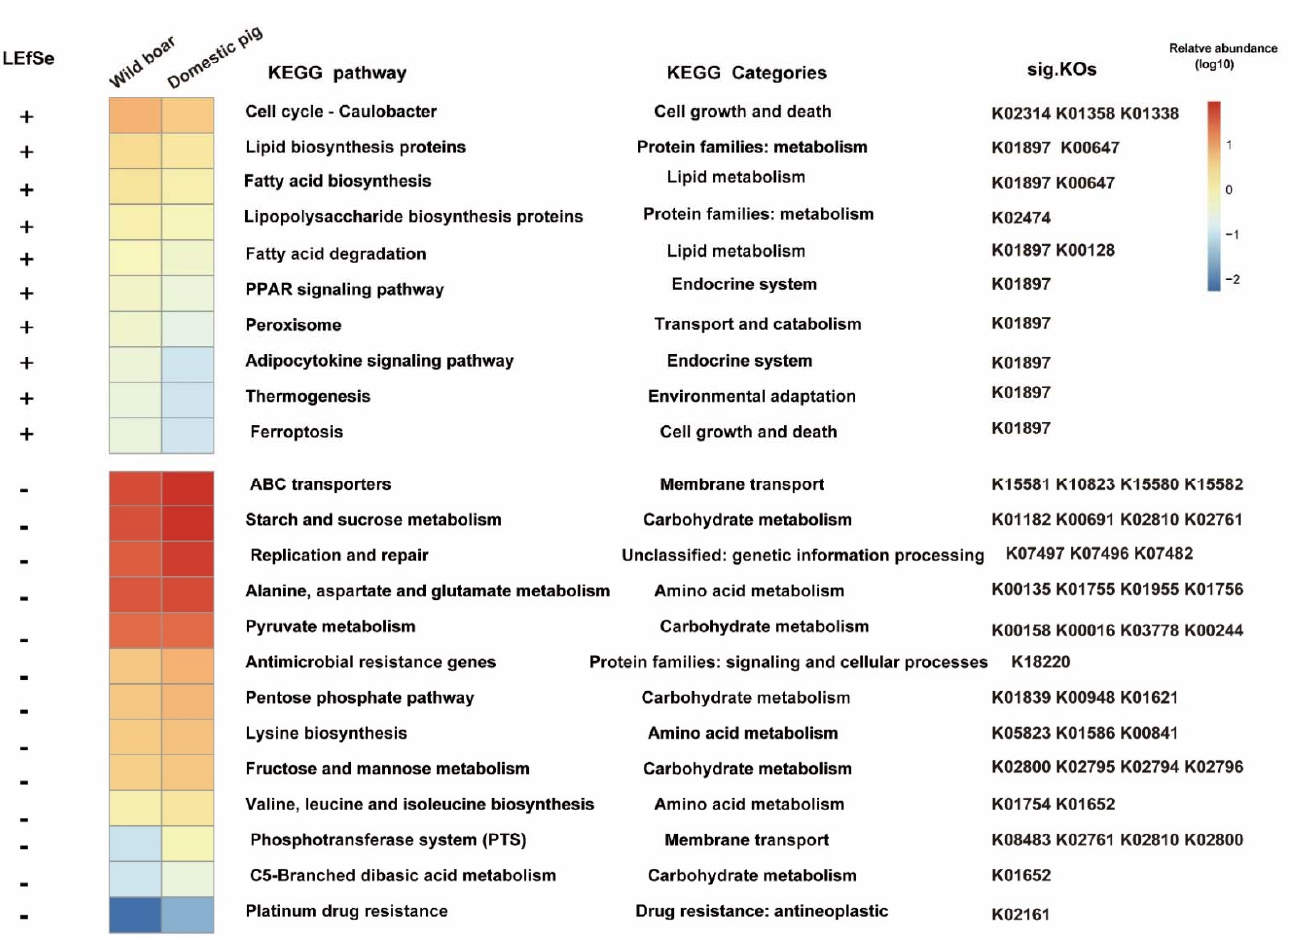
Figure 6. KEGG pathways found to be significantly associated with wild boars and domestic pigs. The average relative abundance of the LEfSe-identified KEGG pathways in the wild boar and domestic pig were plotted as a heatmap. “+” indicates significantly high abundance in wild boar, “-” indicates significantly high abundance in domestic pig ( p < 0.05, LDA cutoff = 2.0). The corresponding KEGG categories and corresponding differential KOs of KEGG pathway are shown on the left.